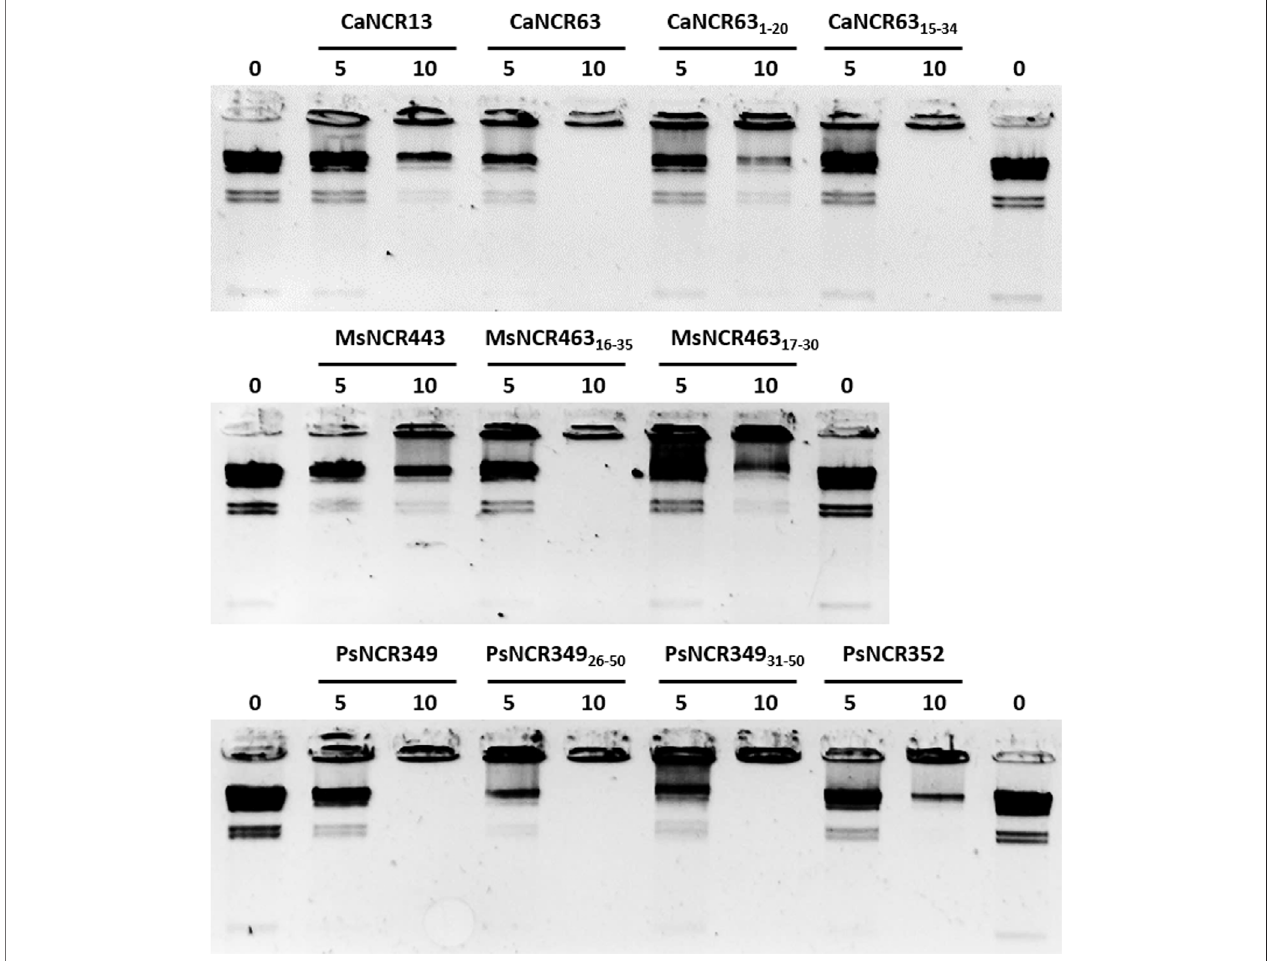
FIGURE 6 | Aggregation of DNA by NCR peptides. Lambda HindIII digested DNA was incubated without (0) or with NCR peptides at 5 or 10 μ M concentration.